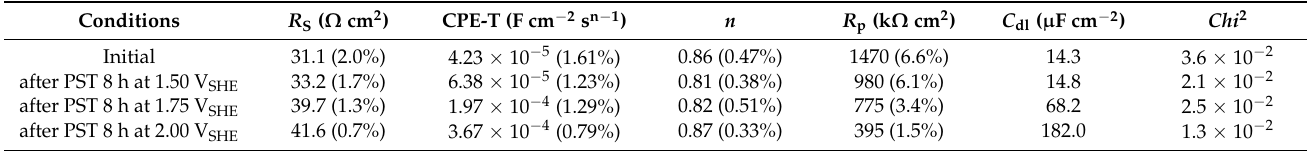
Table 4. Calculated data of the circuit elements and fitting errors (between brackets) for AISI 446 steel